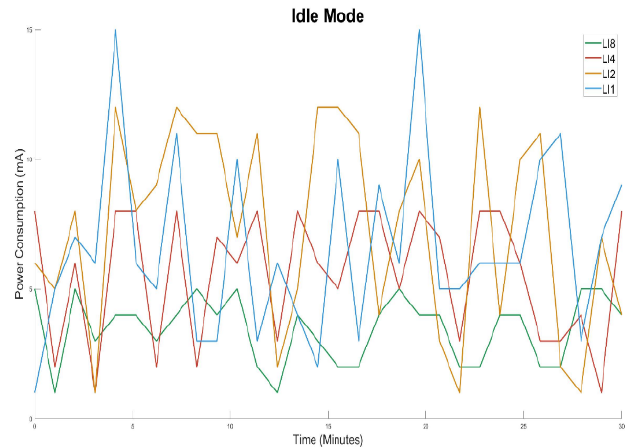
Figure 14. Station Power Consumption in idle mode.